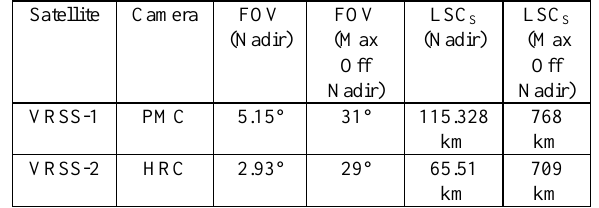
Table 2. VRSS-1and VRSS-2 Satellites Land Swath Coverage Estimation